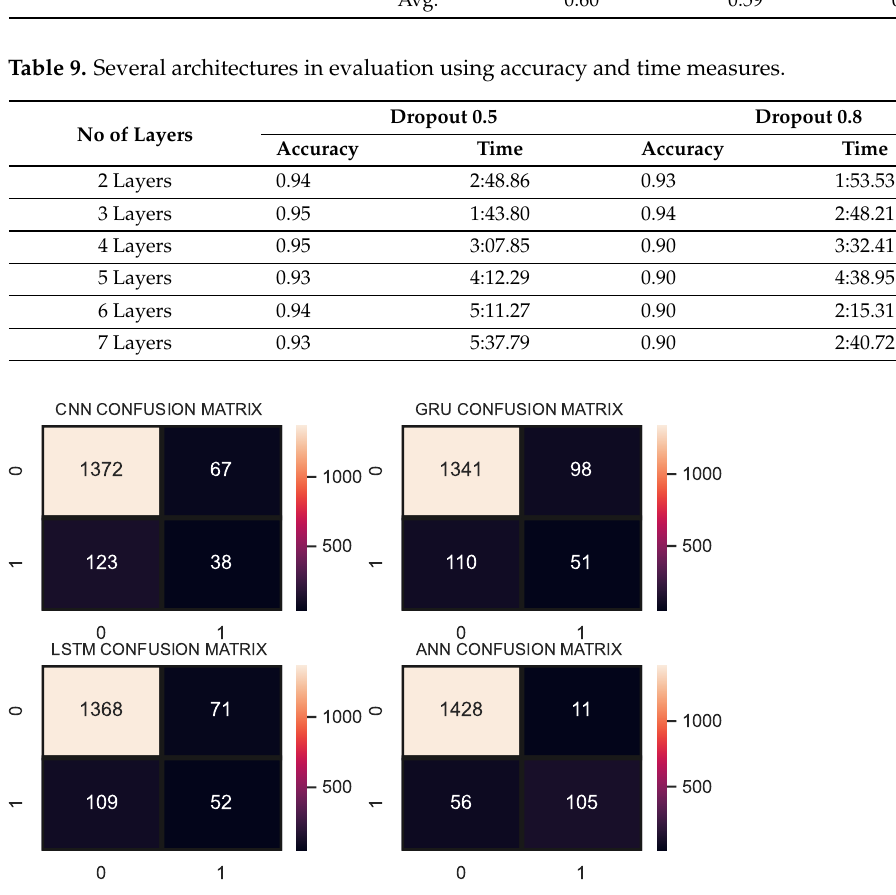
Figure 6. Confusion matrices for deep learning models showing correct and wrong